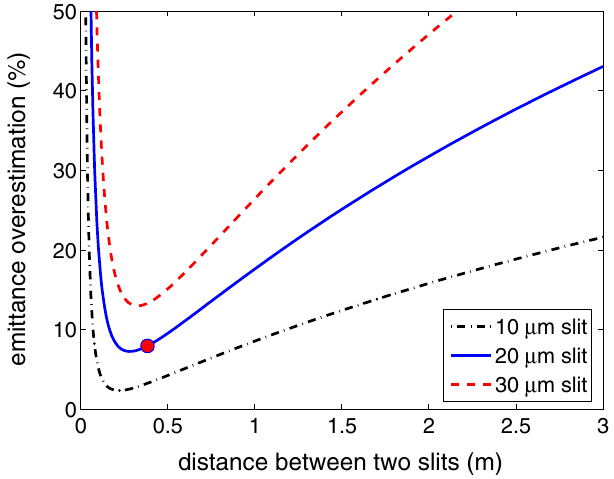
FIG. 5. (Color) Emittance overestimation due to space charge for different slit openings. Beam parameters: (cid:5) n;x;y ¼ 0 : 3 (cid:1) m , rms bunch duration (cid:2) t ¼ 20 ps , (cid:2) x;y ¼ 1 : 3 mm , total rms di- vergence (cid:2) 0 T;x;y ¼ 0 : 72 mrad , kinetic energy 0.5 MeV, and bunch charge 80 pC. The red dot shows the actual separation between the two slits (38